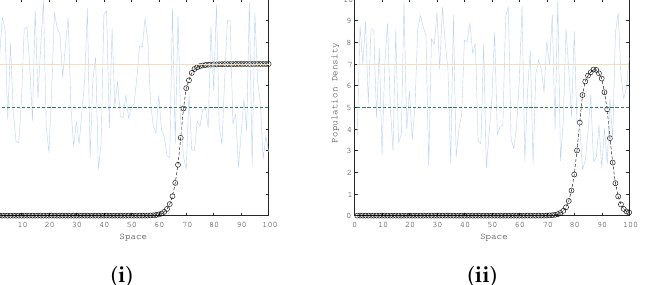
Figure 5. Variation of subpopulation size over space in case of a large coupling q = 20 and β = 7 obtained for two other realizations of the random carrying capacity (generated according to (14)), k ( 2 ) and k ( 3 ) (shown by the thin blue broken line) for ( i , ii ), respectively.